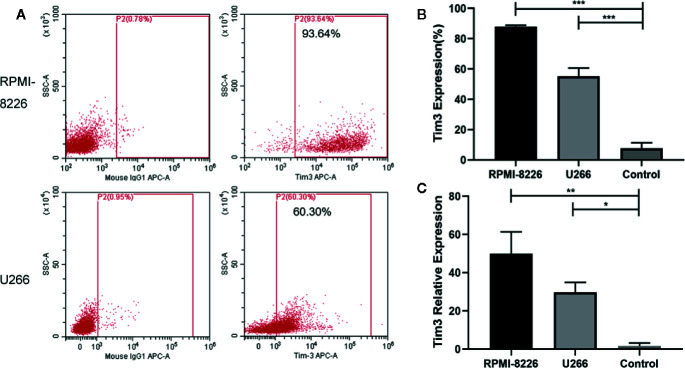
The expression of Tim3 in MM cell lines. (A) The expression of Tim3 in MM cell lines RPMI-8226 and U266. (B) The expression of Tim3 on RPMI-8226, U266, and control by flow cytometry (FCM). Control was from the plasma cells (CD38+ CD138+) of normal healthy people. (C) The expression of Tim3 in RPMI-8226, U266, and control by quantitative real-time polymerase chain reaction (qRT-PCR). Control was from normal healthy people. Shown are average values with standard deviations. Data are performed from 3 independent experiments. * indicated p<0.05, ** indicated p<0.01, *** indicated p<0.001.